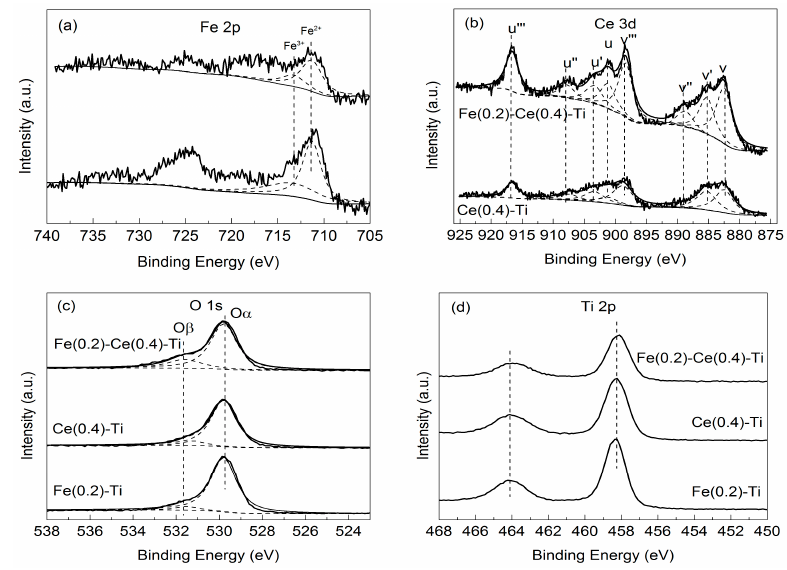
Figure 8. XPS spectra of ( a ) Fe 2p, ( b ) Ce 3d, ( c ) O 1s and ( d ) Ti 2p for Fe(0.2)–Ti, Ce(0.4)–Ti and Fe(0.2)–Ce(0.4)–Ti catalyst. Fe(0.2)–Ce(0.4)–Ti